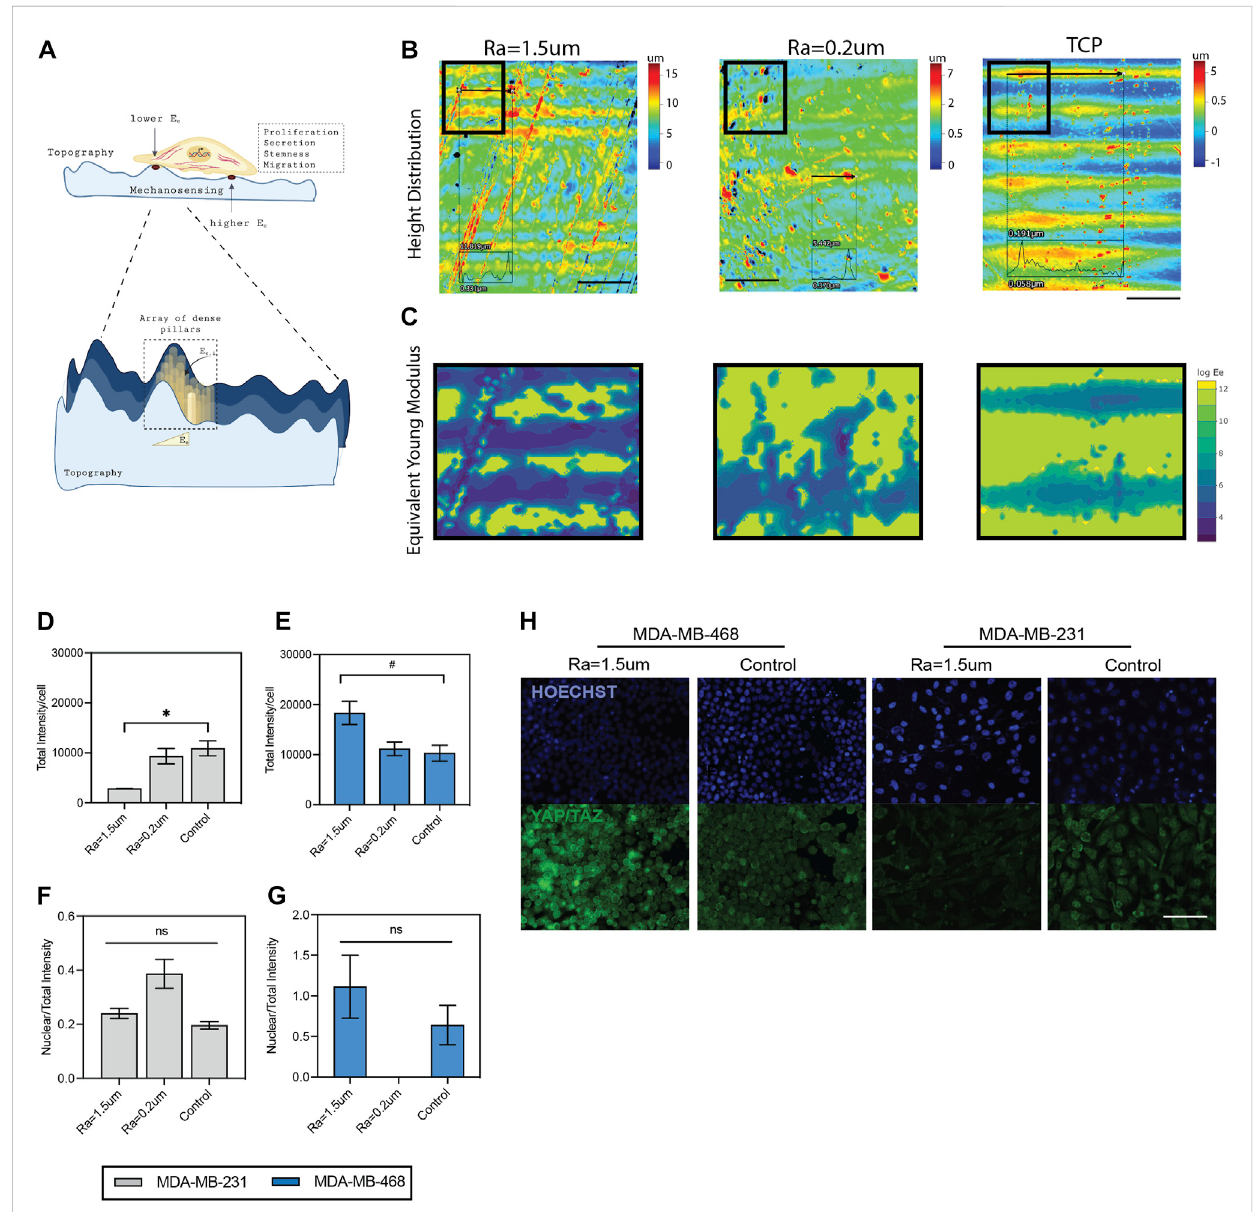
FIGURE 6 Mechanosensing of TNBC cells in surface roughness. (A) Schematic diagram of the mechanosensing of cells in rough surface. Surface forces were estimated as an array of dense pillars with variable heights, as described by (Wei, 2017). (B) Heatmap of height distribution of the surfaces. Scale bar: 500 µm. (C) Contour maps of estimated distribution of forces in the surfaces. Quanti fi cation of total YAP/TAZ per cell in (D) MDA-MB-231 and (E) MDA- MB-468cellsculturedinsurfaceswithroughness,comparedtoTCPcontrol.RatiobetweennuclearYAP/TAZintensityandtotalYAP/TAZintensityin (F) MDA-MB-231 and (G) MDA-MB-468 cells cultured in surfaces with roughness, compared to TCP control. (H) Representative immuno fl uorescence images of YAP/TAZ (green) and nuclei (blue) staining. Scale bar: 100 µm. Error bars depict the mean ± SEM of 2 independent experiments with n = 2 samples. T -test with Mann-Whitney non-parametric test. Asterisk (*) represent p -values < 0.05, (**) p -values < 0.01, (***) p -values < 0.001 and (****) p -values < 0.0001, (#) p -values <